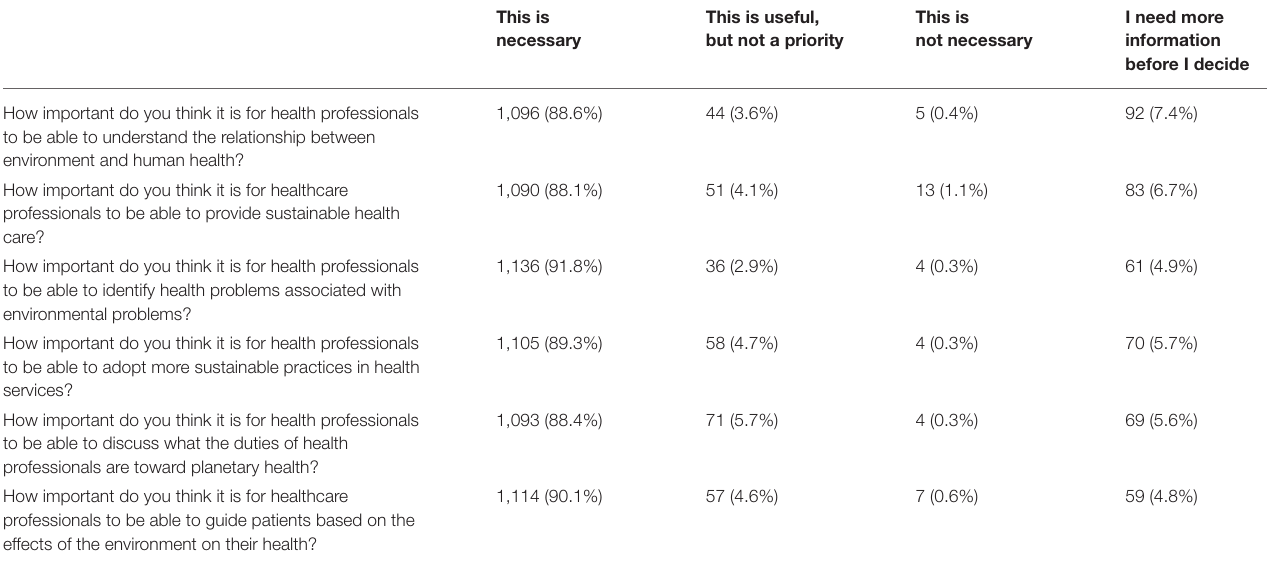
TABLE 3 | Previous knowledge and awareness about planetary health ( n = 1,237).